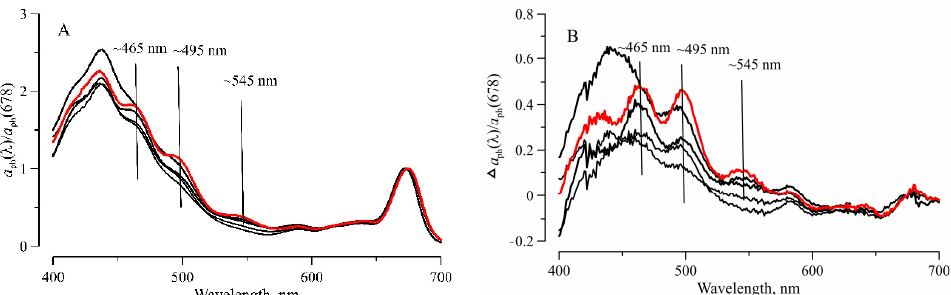
Figure 13. Phytoplankton light absorption spectra ( a ph ( λ ) ) normalized on its value at red maximum ( a ph ( 678 ) ) at stations (6585, 6609, 6614, 6631, RS4) ( A ); the difference between spectra a ph ( λ ) / a ph ( 678 ) with and without local maxima ( B ). The red line denotes the spectrum with a more pronounced local maximum at station 6609.